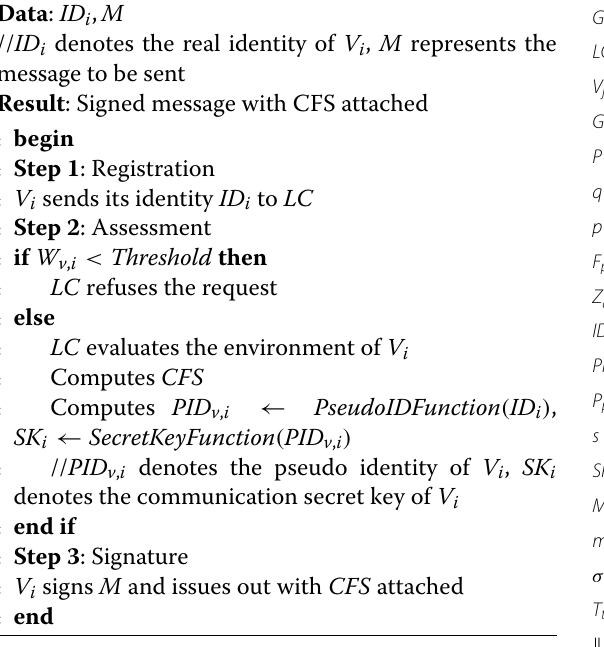
Algorithm 2 Process to issue messages in our scheme